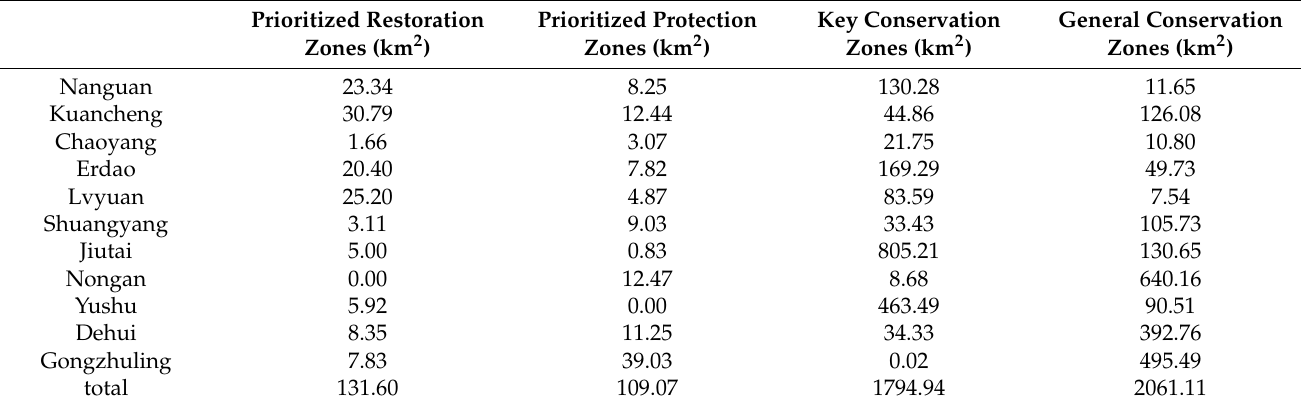
Figure 7. Ecological restoration zones (( a , b ), are partially enlarged views). Table 3. Distribution of the area of each county in the ecological restoration zone.